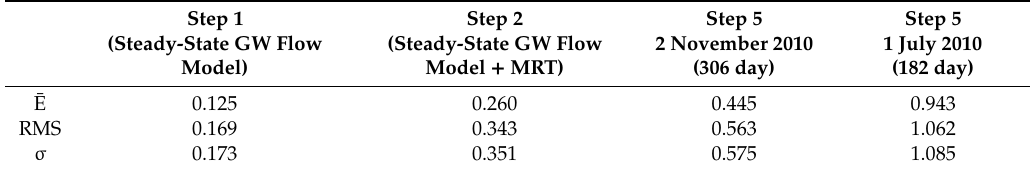
Table 5. Statistics of the calibrated models after steps one, two, and five. Statistics for the calibrated transient state model (after step five) are presented for two days 2 November 2010 and 1 July 2010, when the Sava River recharge was high and low,